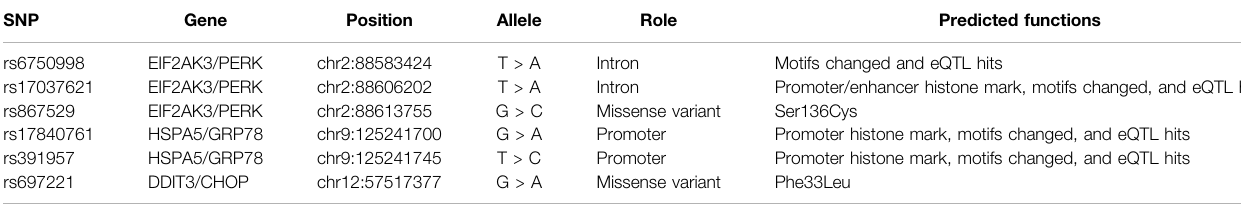
SNP, single-nucleotide polymorphism; eQTL, expression quantitative trait locus.